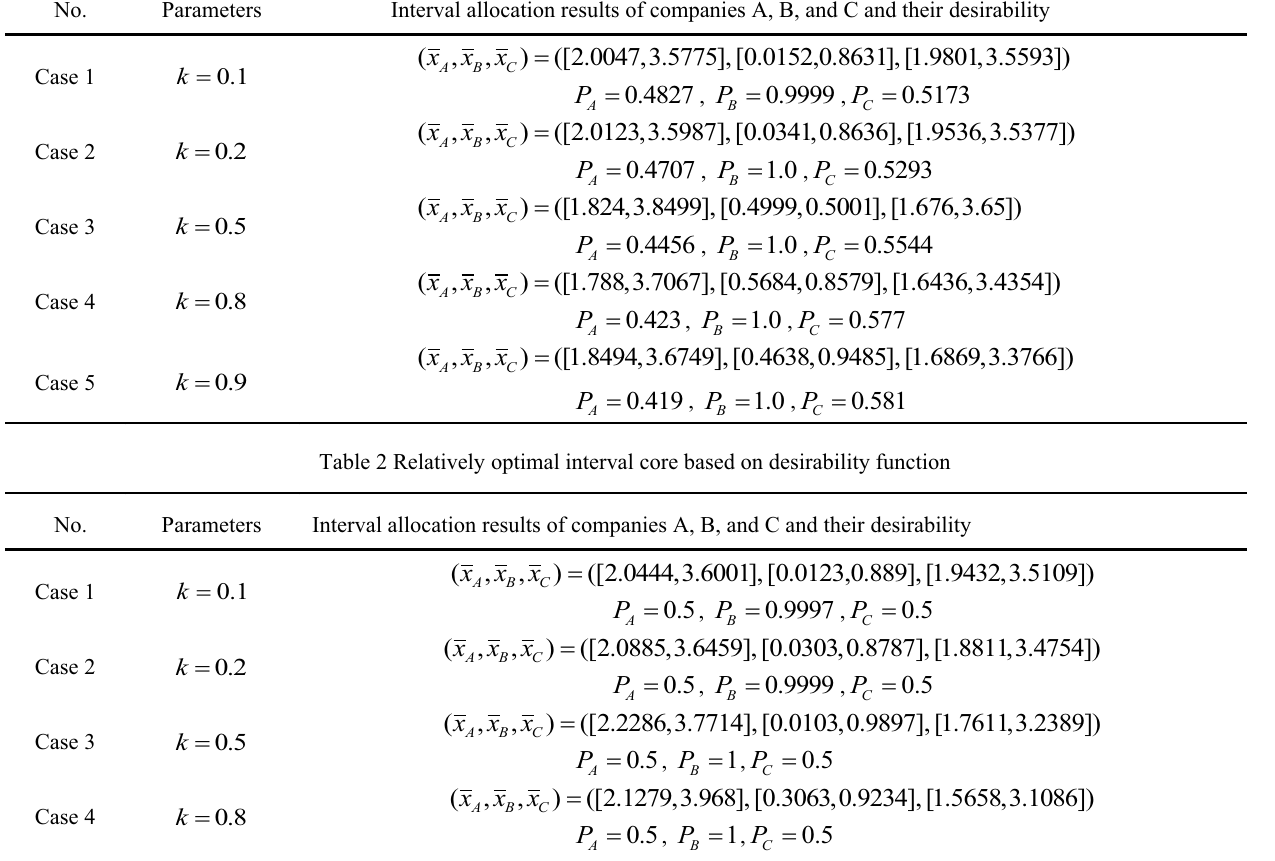
Table 1 Relatively optimum interval core based on desirability function No. Parameters Interval allocation results of companies A, B, and C and their desirability